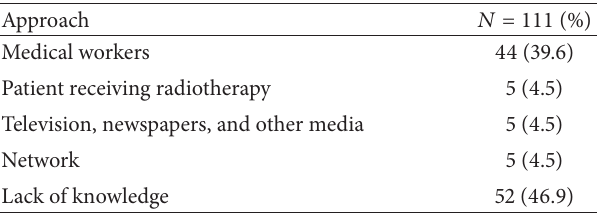
Table 3: Approaches to get the knowledge of pre-CRT.